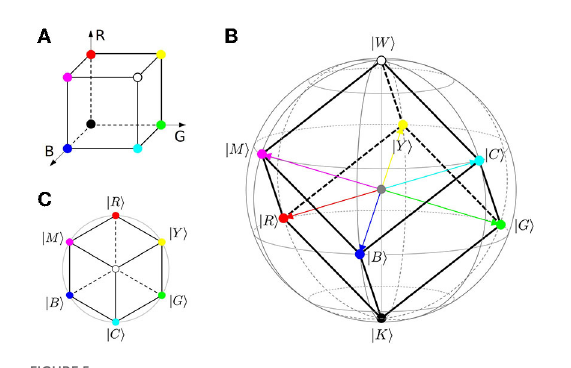
FIGURE5 Building of the qubit-color space. RGB color cube (A) is inscribed in the Bloch sphere (B) such that white (W) and black (K) map to the basis states 1 and 0 . Primary RGB (Equation 11) | i | i and secondary CMY (Equation 13) colors define horizontal planes, dividing the diameter of the sphere into three equal parts. (C) : View from the black-white diagonal. Main chromatic colors form the rainbow sequence seen in the equator of the HSL bi-cone (Figure 4).